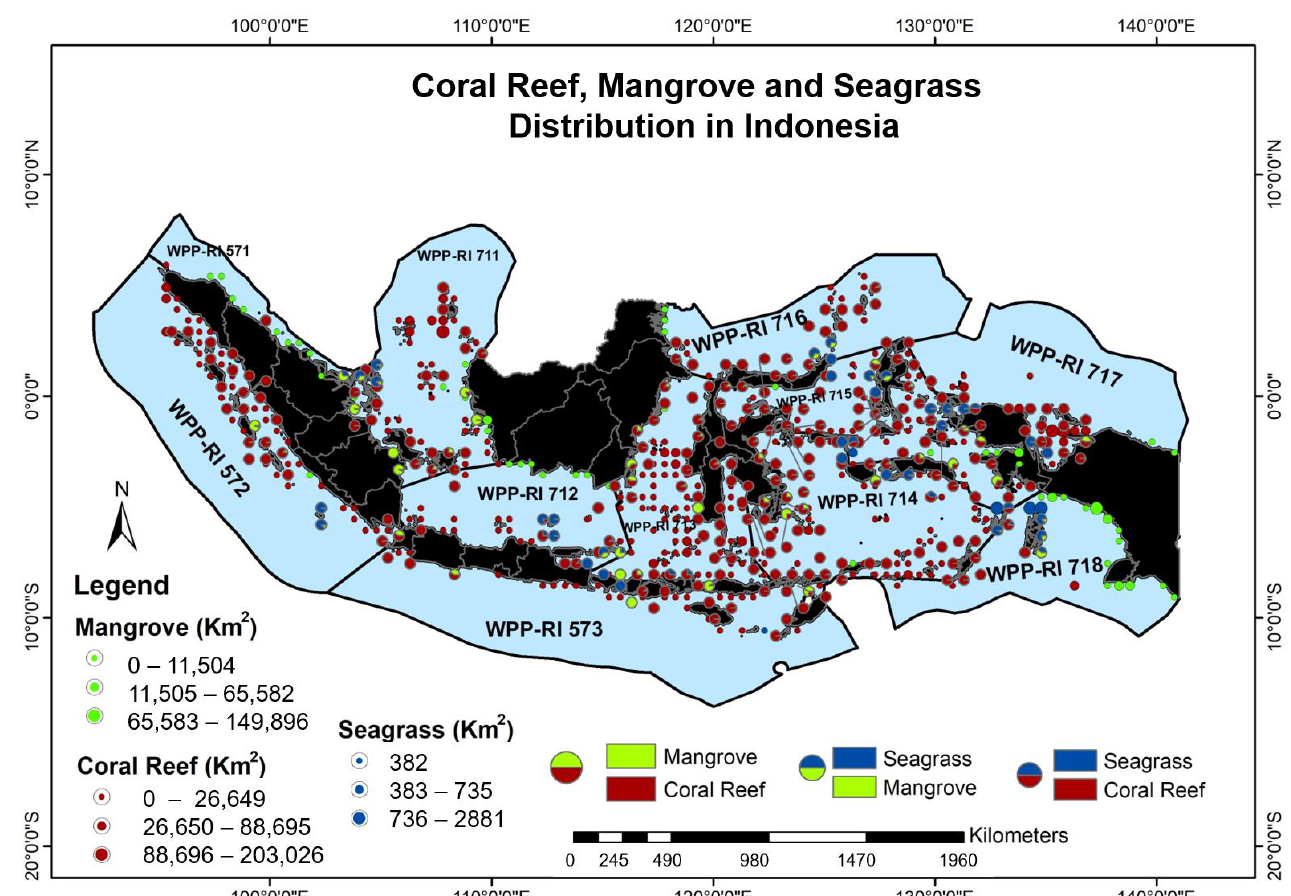
Figure 1. Blue carbon ecosystem distribution in Indonesia and WPP-RI [61 – 63].